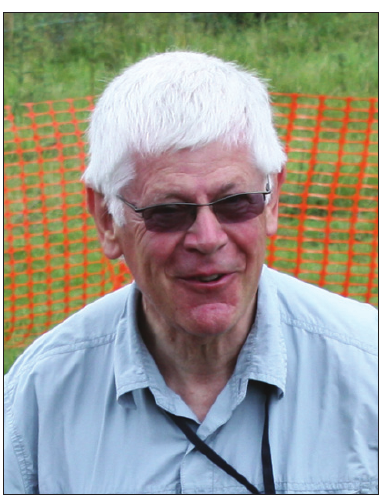
Figure 2: Dai Morgan Evans (Photo Howard